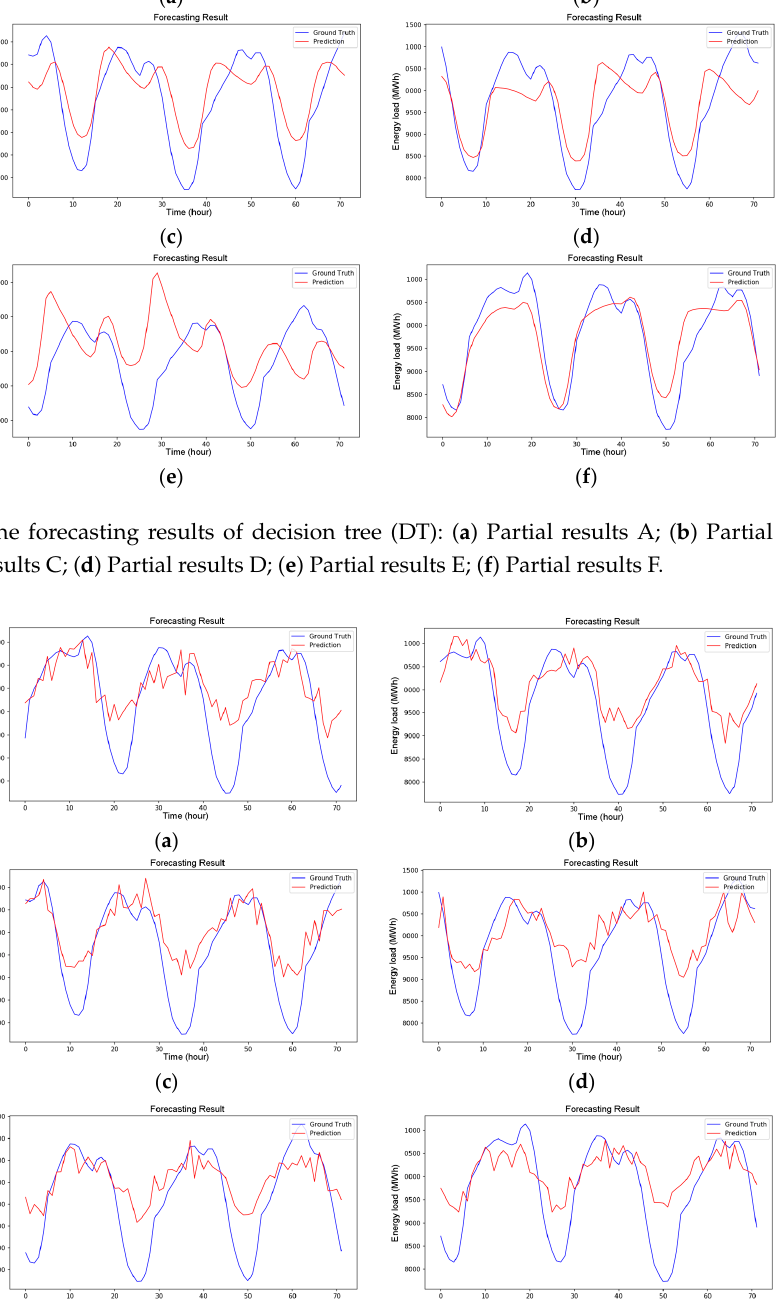
Figure 9. The forecasting results of Multilayer Perceptron (MLP): ( a ) Partial results A; ( b ) Partial results B; ( c ) Partial results C; ( d ) Partial results D; ( e ) Partial results E; ( f ) Partial results F.